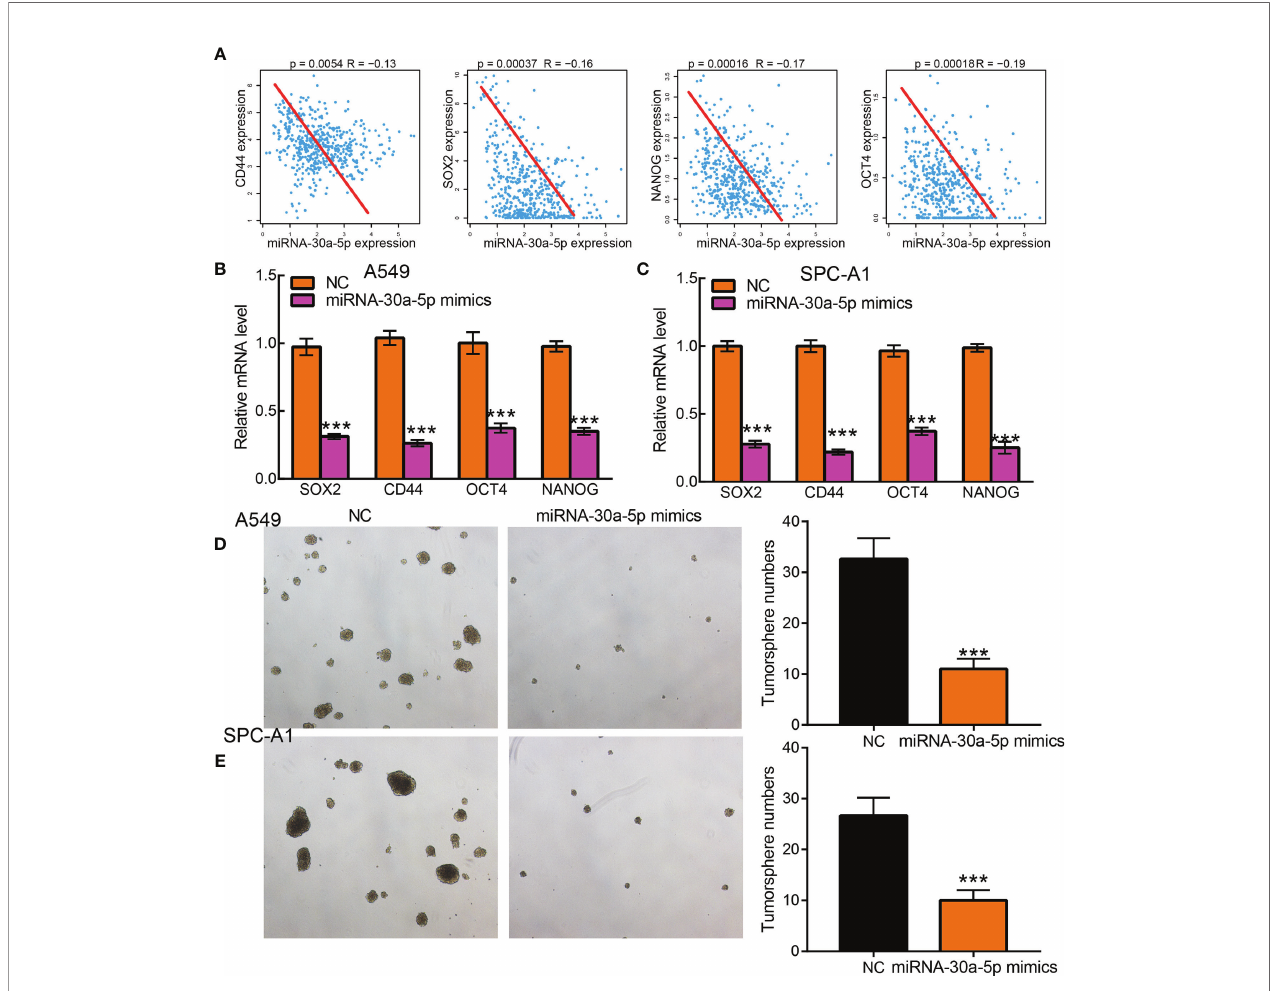
FIGURE 9 | Over-expression of miRNA-30a-5p inhibits cancer stem cell maintenance in LUAD. (A) The correlation between miRNA-30a-5p and cancer stem cell maintenance-related factors, including SOX2, CD44, OCT4, and NANO in TCGA-LUAD, was examined using Pearson ’ s correlation analysis. (B, C) Relative mRNA expressions of cancer stem cell marker genes, including CD44, OCT4, SOX2, NANOG in A549, and SPC-A1cells, were examined by Real-time RT-PCR upon over- expression of miRNA-30a-5p. (D, E) Tumor sphere formation abilities of indicated cells after over-expression of miRNA-30a-5p were examined by tumorsphere assay. Scale bar=50 m m. . ***P <